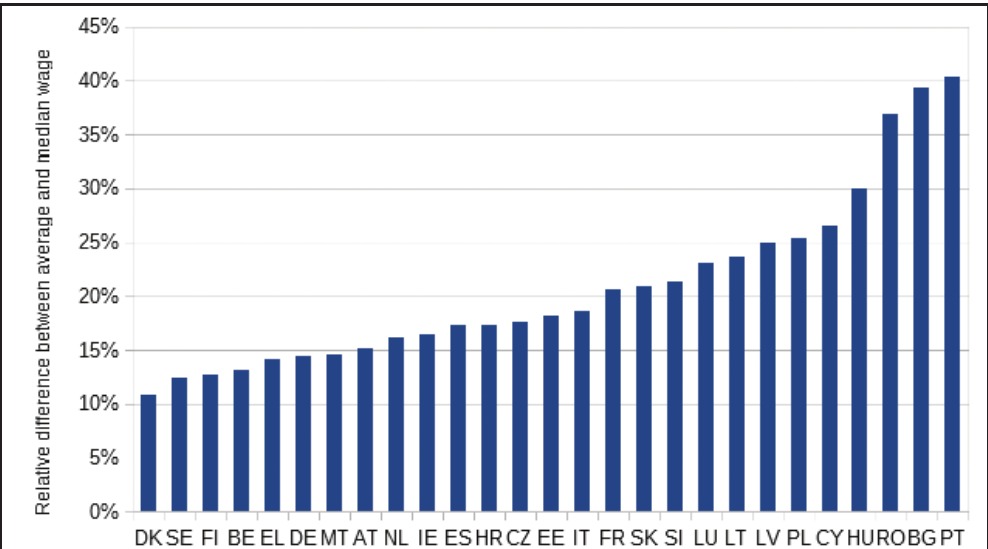
Figure A2 The relative difference between the average and the median wage, 2019.